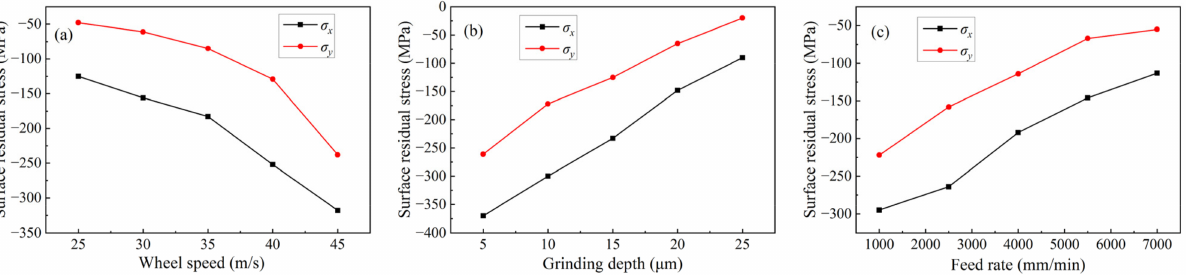
Figure 6. Surface residual stress under different grinding parameters: ( a ) Wheel speed; ( b ) Grinding depth; ( c ) Feed